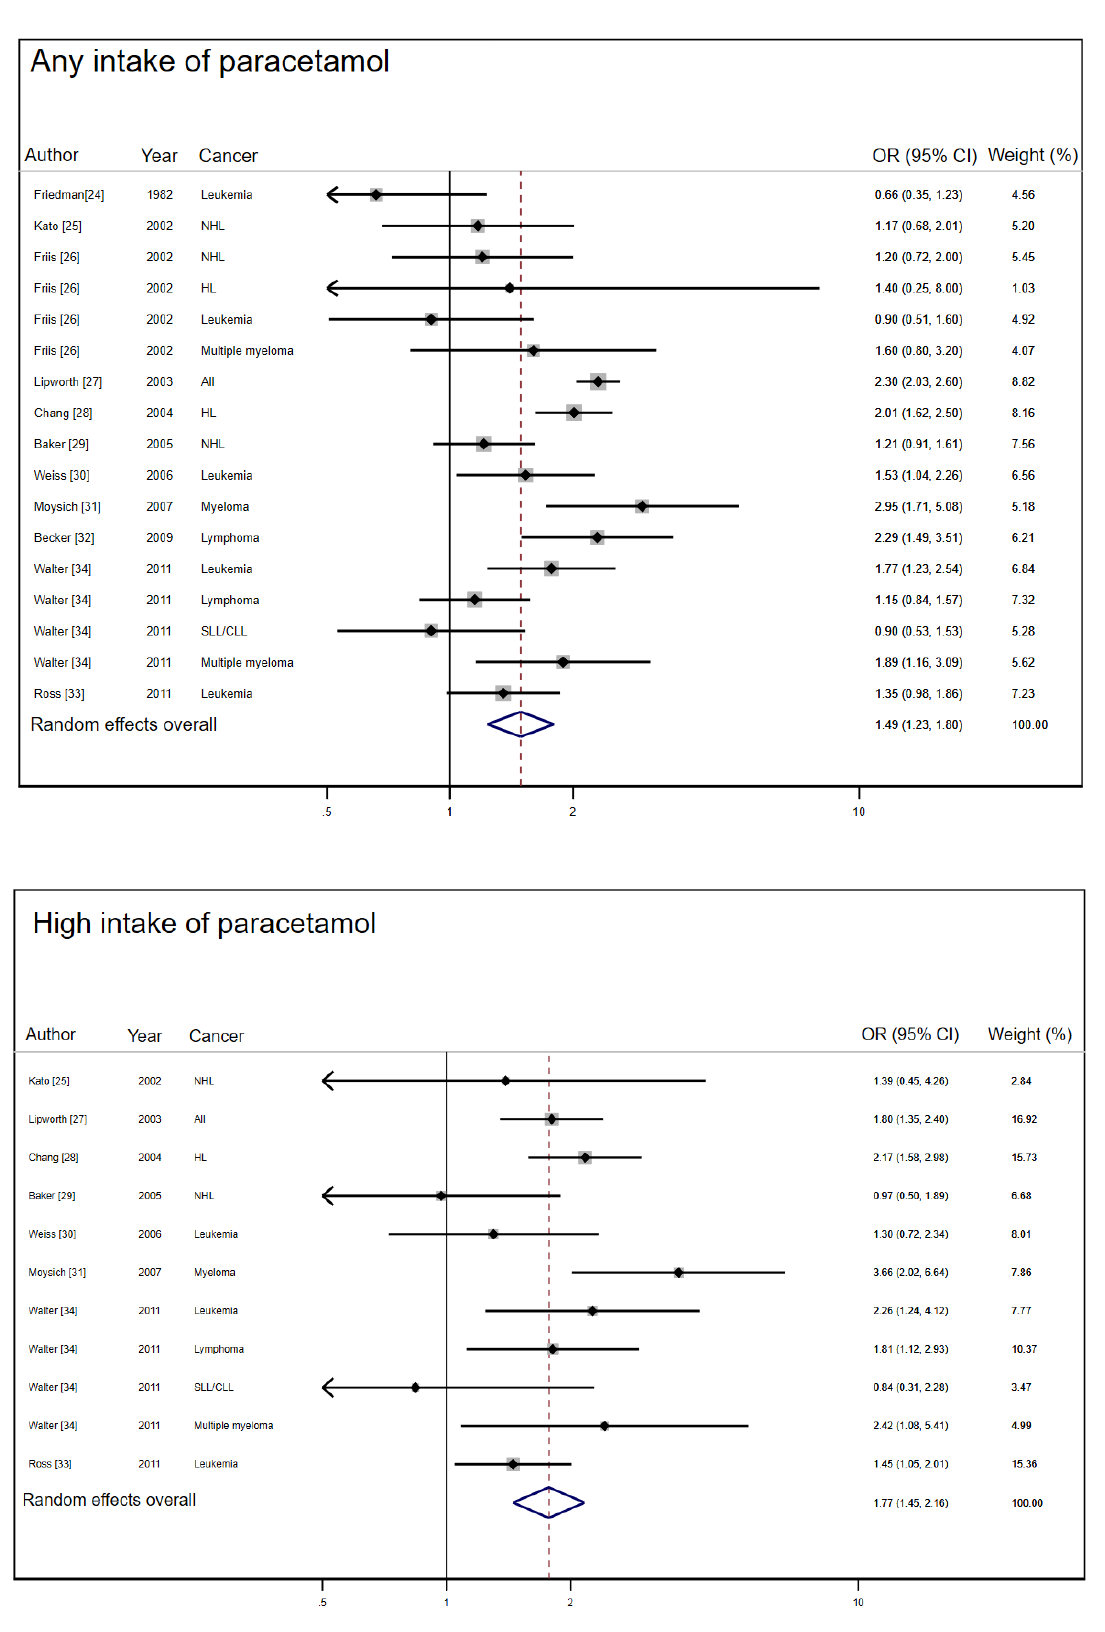
Figure 2. Forest plots of studies included in the meta-analysis of paracetamol intake and hematologic